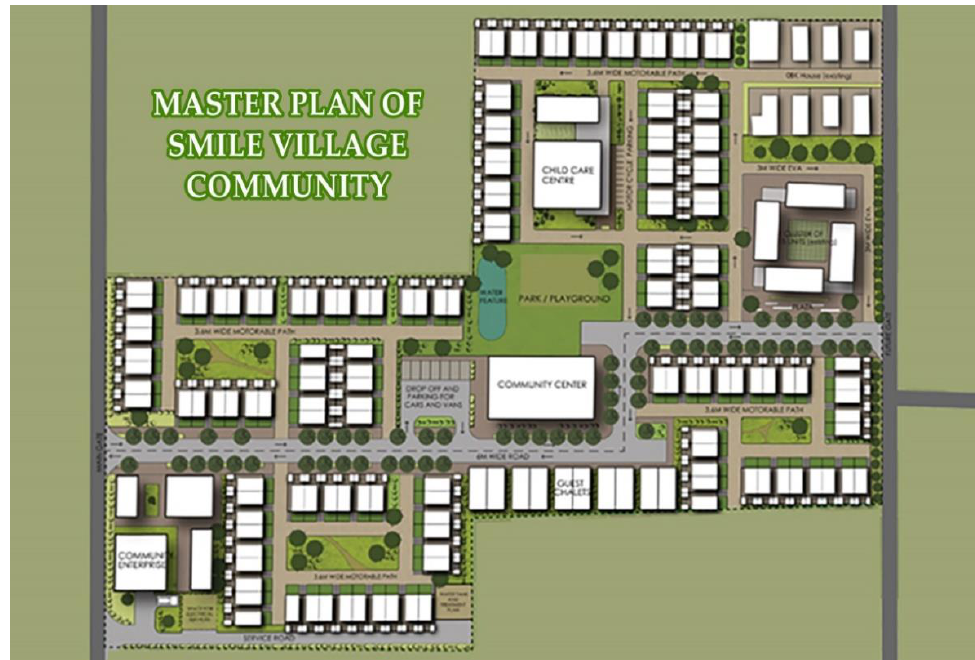
Figure 2. Masterplan of Smile Village community. Source: Smile Village management.